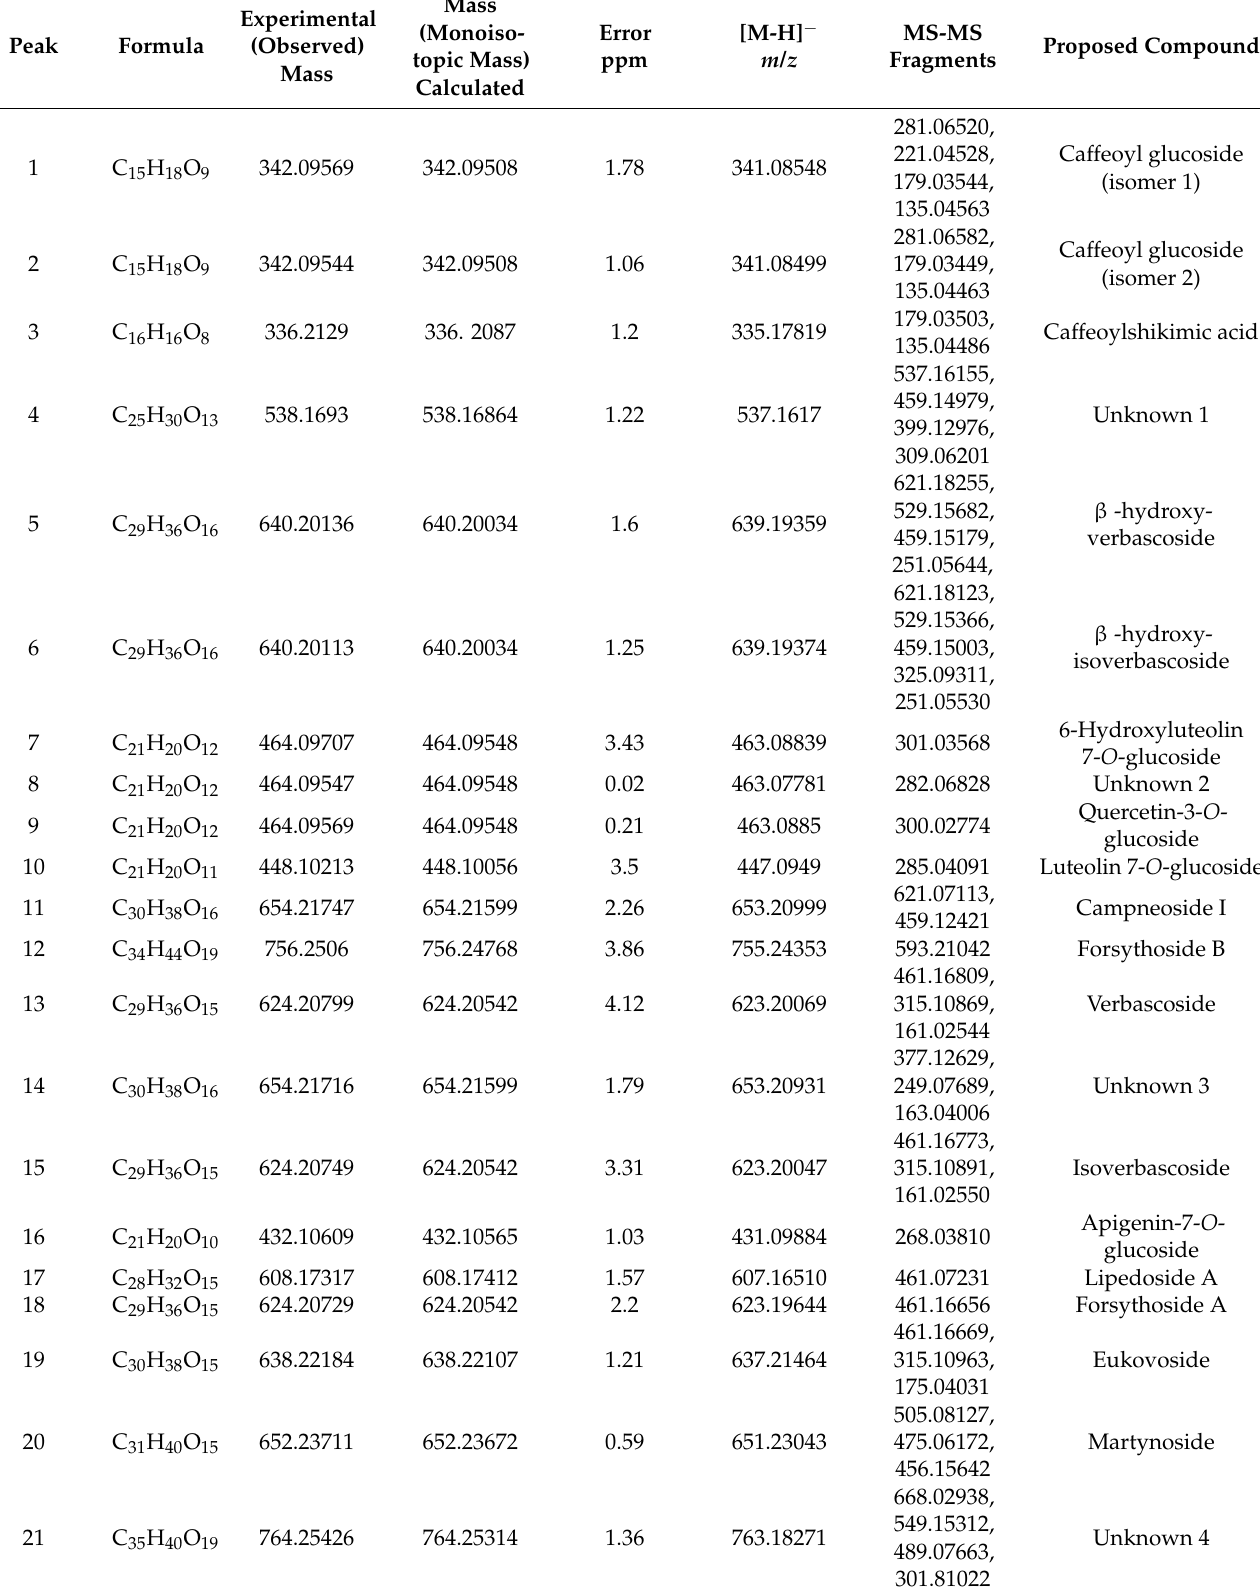
Table 2. Identification of targeted phenolic compounds from Buddleja globosa by LC-ESI-QTOF/MS-MS.